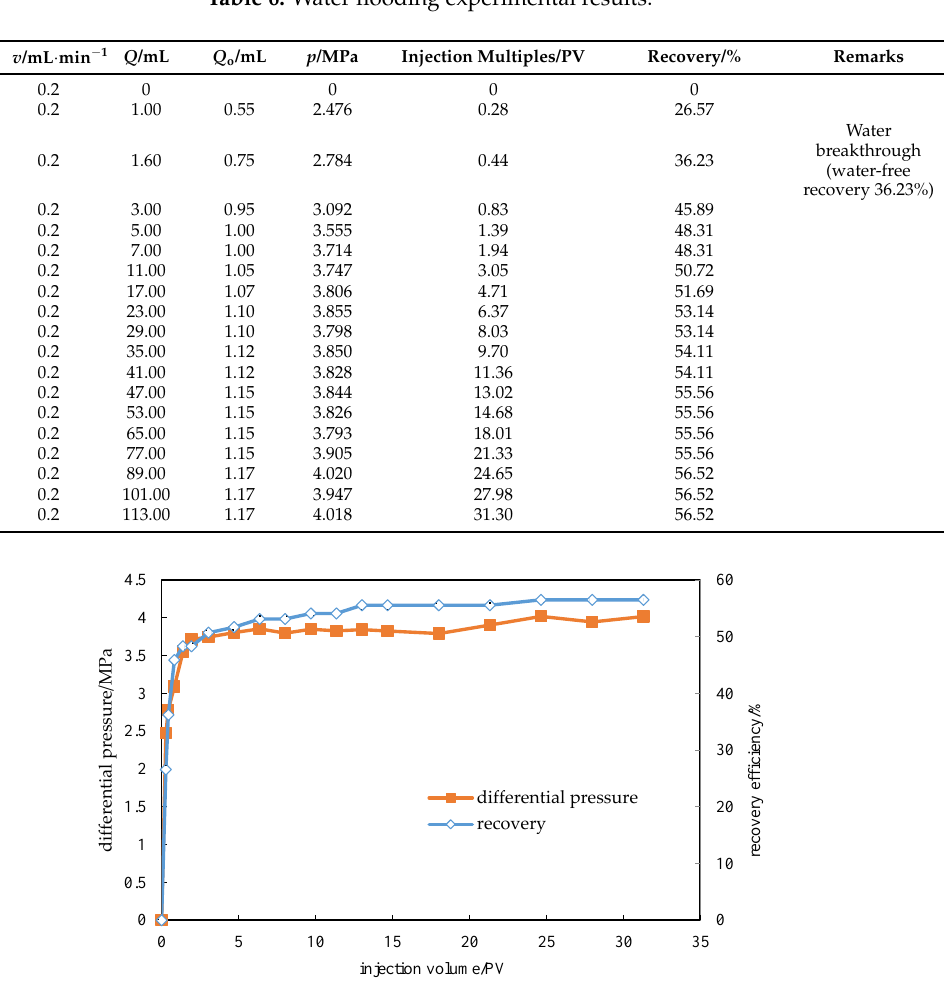
Figure 4. Pressure difference, recovery ratio relationship of injection multiples.